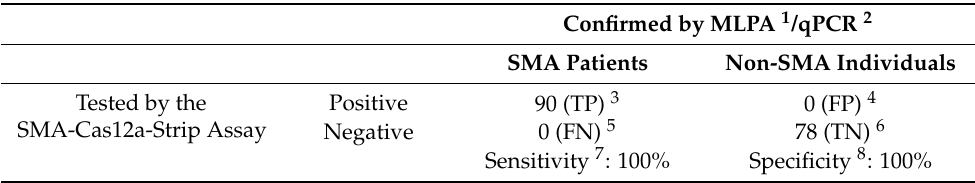
Table 1. The analytical performance of the SMA-Cas12a-strip